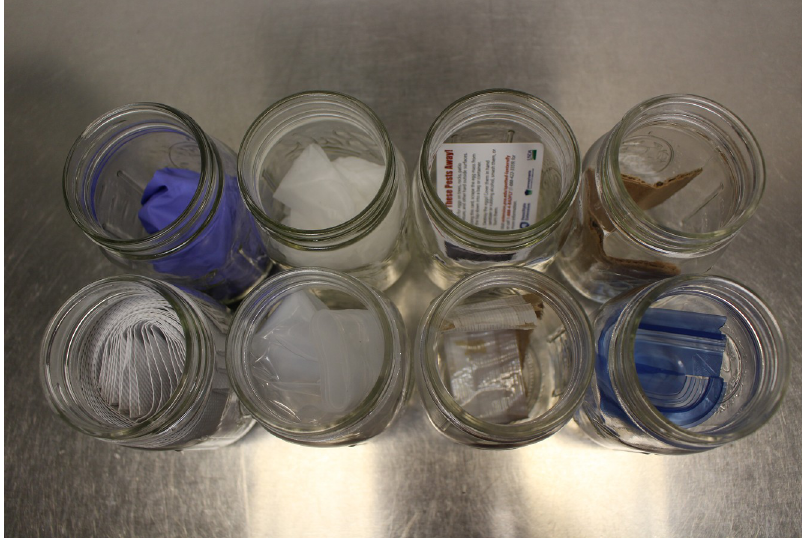
Fig 6. Picture of the non-bark controls, counterclockwise from top-left: Nitrile gloves, vinyl gloves, plastic scraper, cardboard, paper towels, plastic shipping material, tape, and pieces of plastic storage containers.